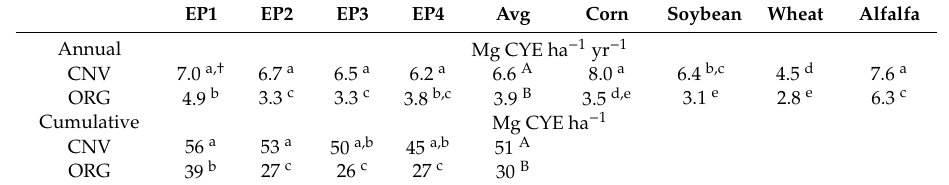
† Lowercase letters indicate significant di ff erences among system by entry point factors or among system by crop factors. Uppercase letters indicate significant overall di ff erences between